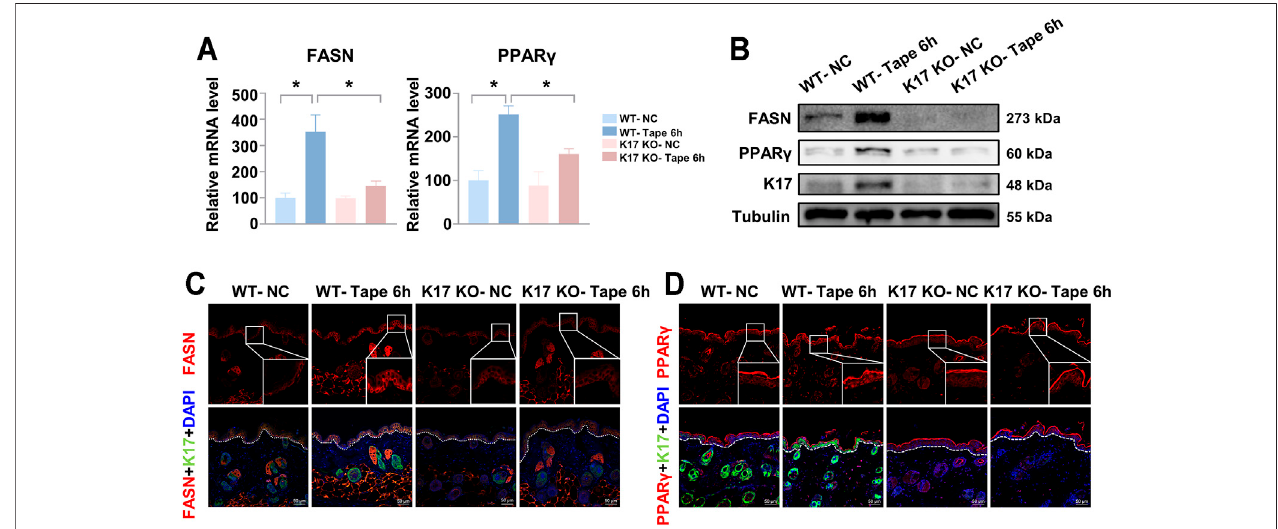
FIGURE3 | Keratin 17 knockout abolishes theupregulation offatty acid synthase (FASN) (epidermal lipid synthesis enzyme) and peroxisome proliferator-activated receptorgamma(PPAR γ )(transcriptionfactor)expressionafter epidermalbarrierdisruption invivo .Theshaved skininthebacksofkeratin 17( Krt17 )knockoutandwild- type (control) mice was disrupted using tape stripping. The skin was collected for analysis 6 h after tape stripping. (A) Quantitative real-time PCR results of the relative mRNA expression levels of the epidermal lipid synthesis enzyme, FASN and the transcription factor, PPAR γ . Data were normalized to non-tape-stripped wild-type controls(controlsweresetas100%).Dataarerepresentativeofatleastthreeindependentexperimentsandeachgroupconsistedofthreemice. (B) Theproteinlevelsof FASN, PPAR γ , and K17 were measured in each group of mice. Tubulin served as the loading control. (C,D) Immuno fl uorescence staining of FASN and PPAR γ . Scale bars (cid:1) 50 μ m. Results are shown as means ± SEM. * p <